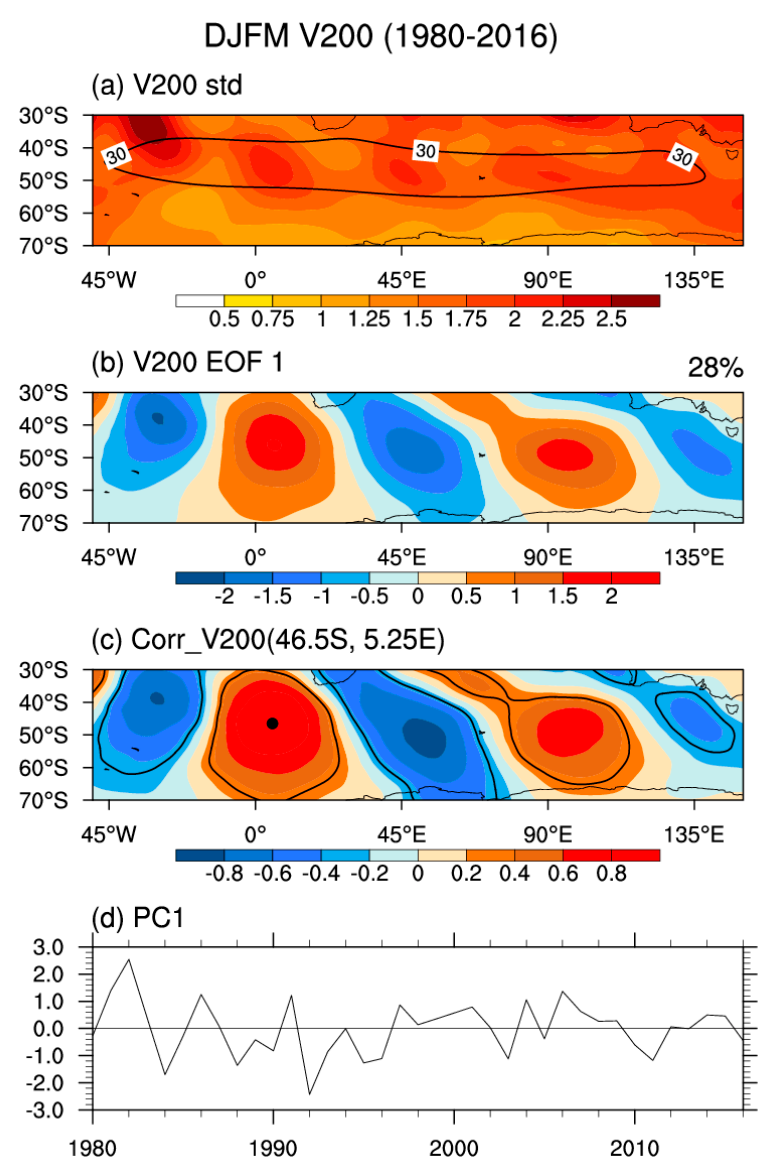
Figure 1. Basic features of meridional winds at 200 hPa (V200, unit: m s –1 ) over 30°–70° S, 50° W–150° E in austral summer (December-January-February-March, DJFM): ( a ) standard deviation, ( b ) the first EOF (EOF 1) mode, ( c ) one-point correlation of V200 for the reference location (46.5° S, 5.25° E) depicted by the filled black circle, and ( d ) the principal component corresponding to the EOF1 mode (PC1). Black contour in ( a ) depicts the climatological Southern Hemisphere westerly jet with zonal wind at 200 hPa exceeding 30 m s –1 and in ( c ) represents significance at the 95% confidence level based on Student’s t -test. The EOF 1 mode explains 28% of total interannual variance.